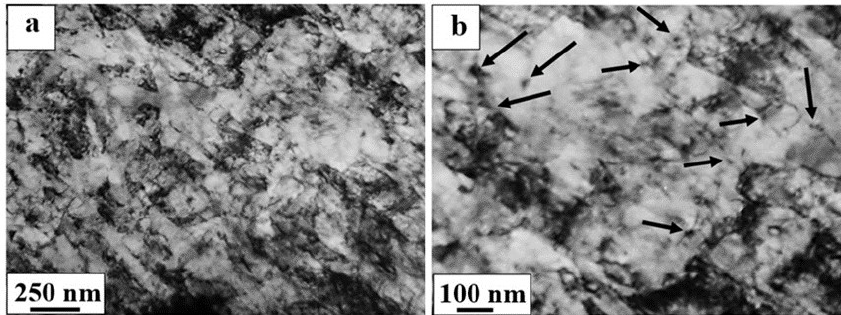
Figure 5. Electron microscopic images of ‘ferrite-carbide mixture’ structure of surface layer. Arrows indicate in (b) the particles of carbide